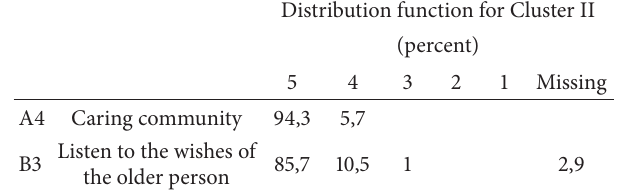
Table 4: Cluster II: Community.